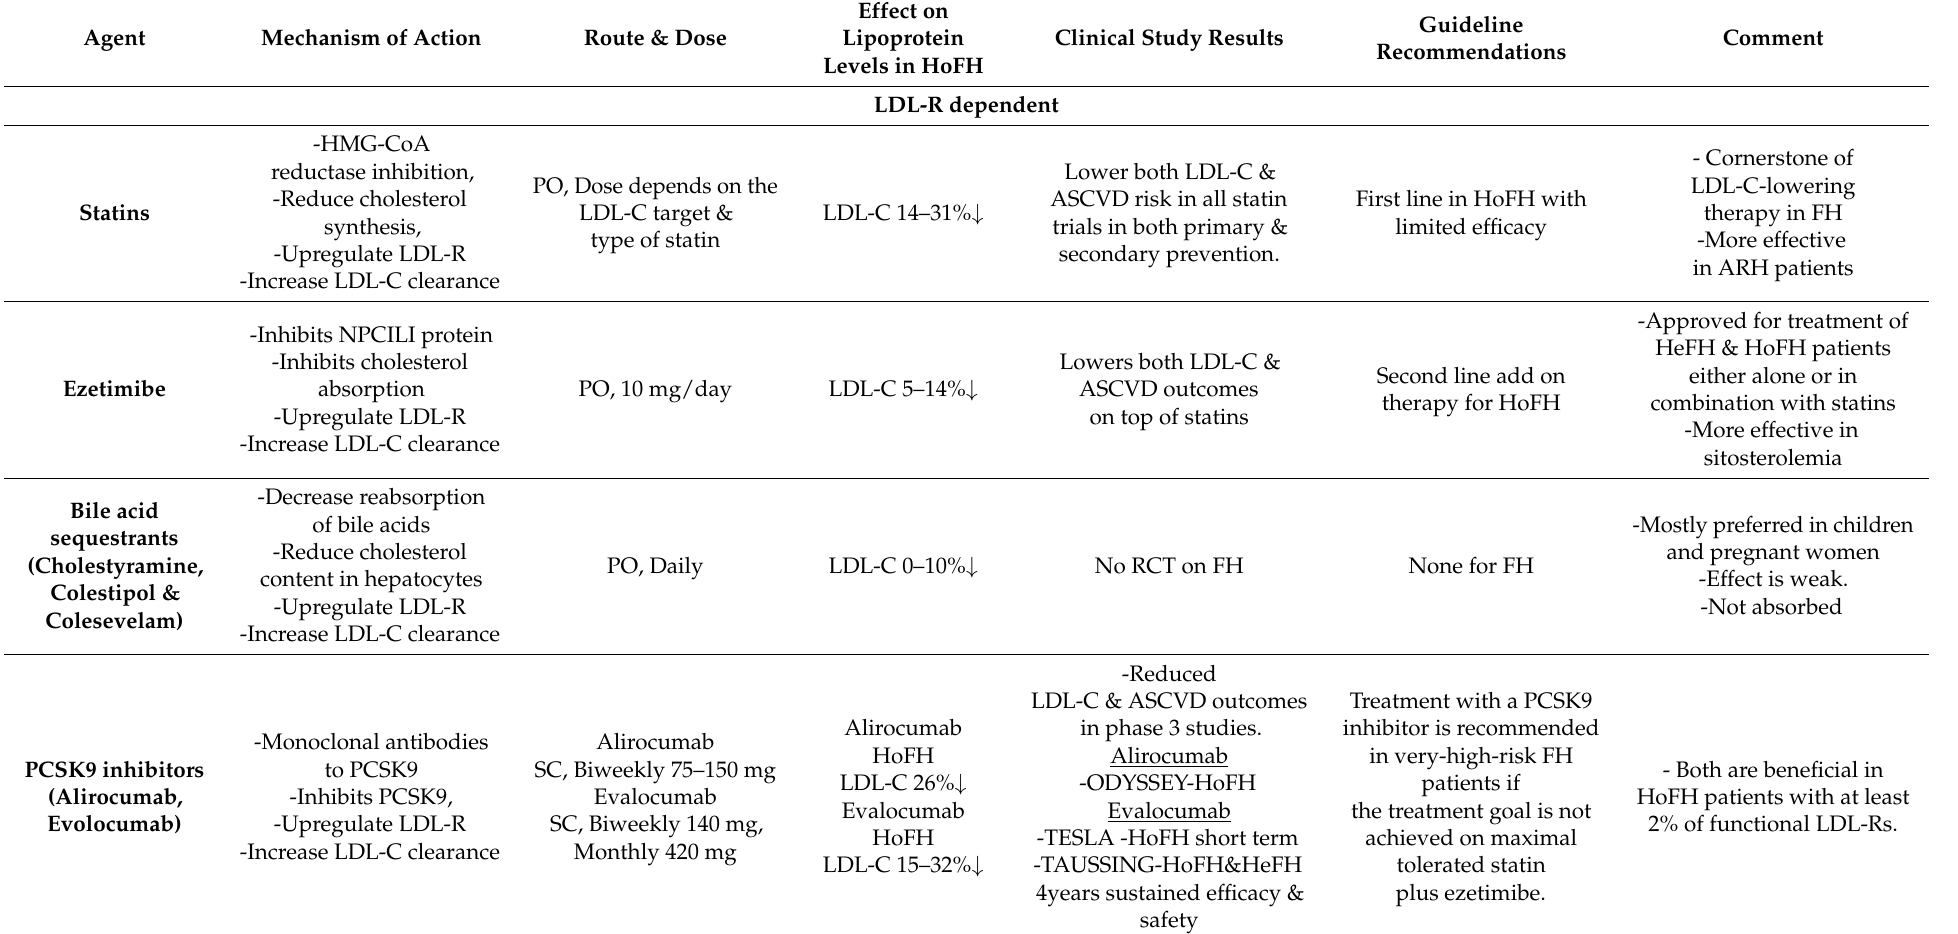
Table 1. Lipid lowering therapies for patients with Homozygous familial